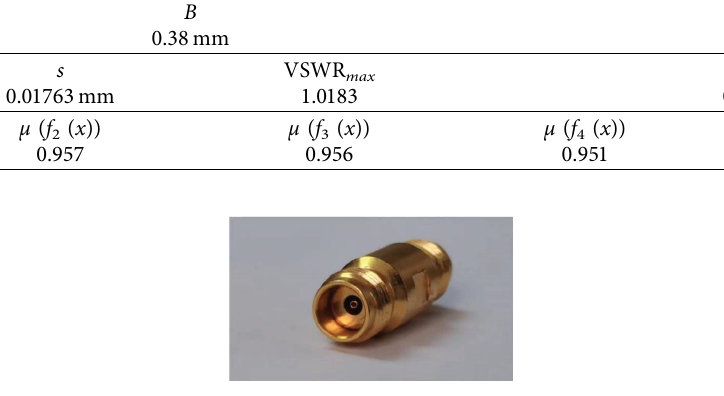
Figure 8: 65 GHz · millimeter-wave